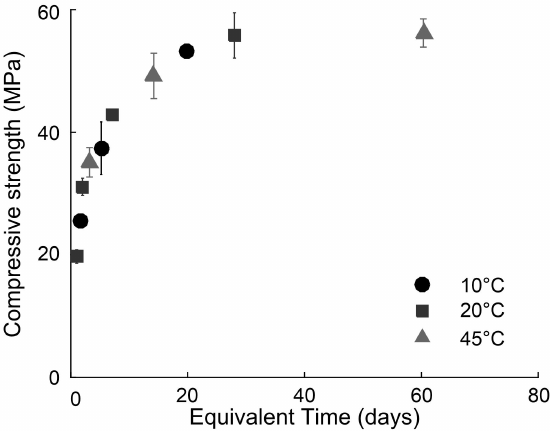
Figure 11. Compressive strength as a function of equivalent